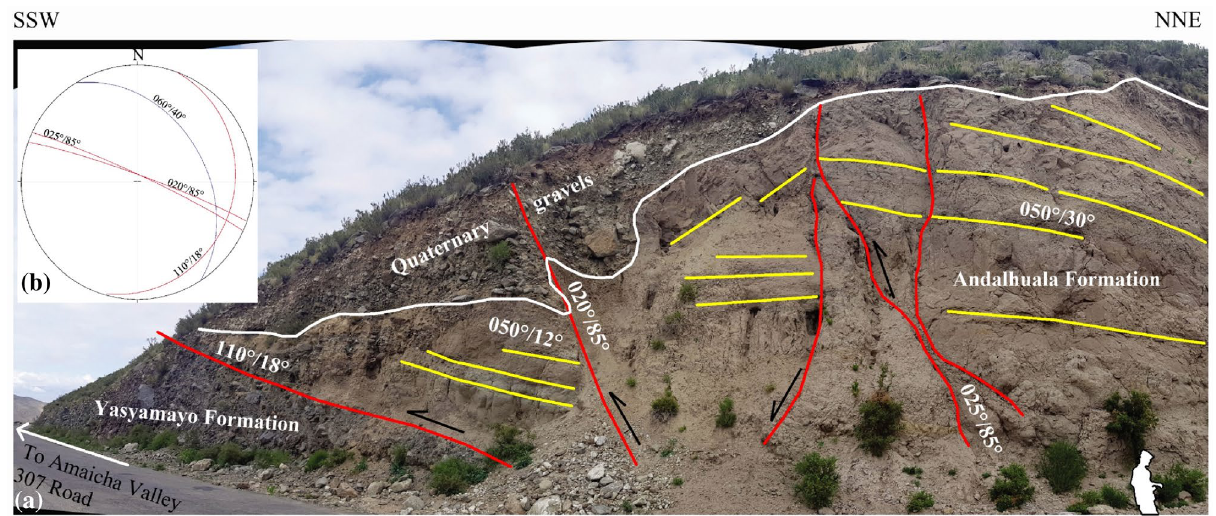
edge, in white, a person’s half‑length silhouette indicates scale. b Diagram of resulting fractures represented in Schmidt’s equiareal network, lower hemisphere. Los Cardones fault in blue line. In red lines faults in this